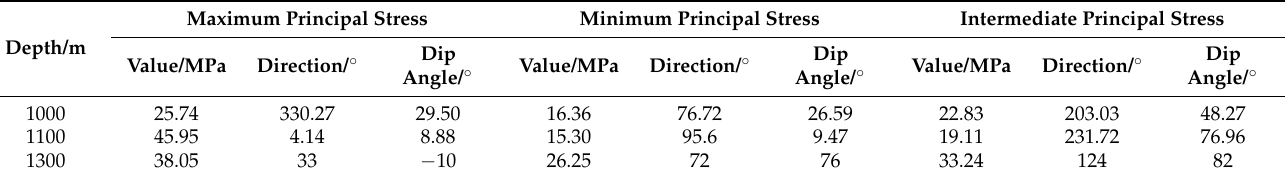
Table 3. In situ stress